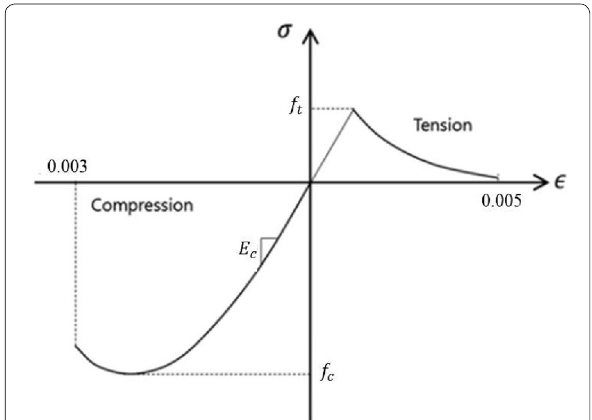
Fig. 4 Uniaxial concrete model.